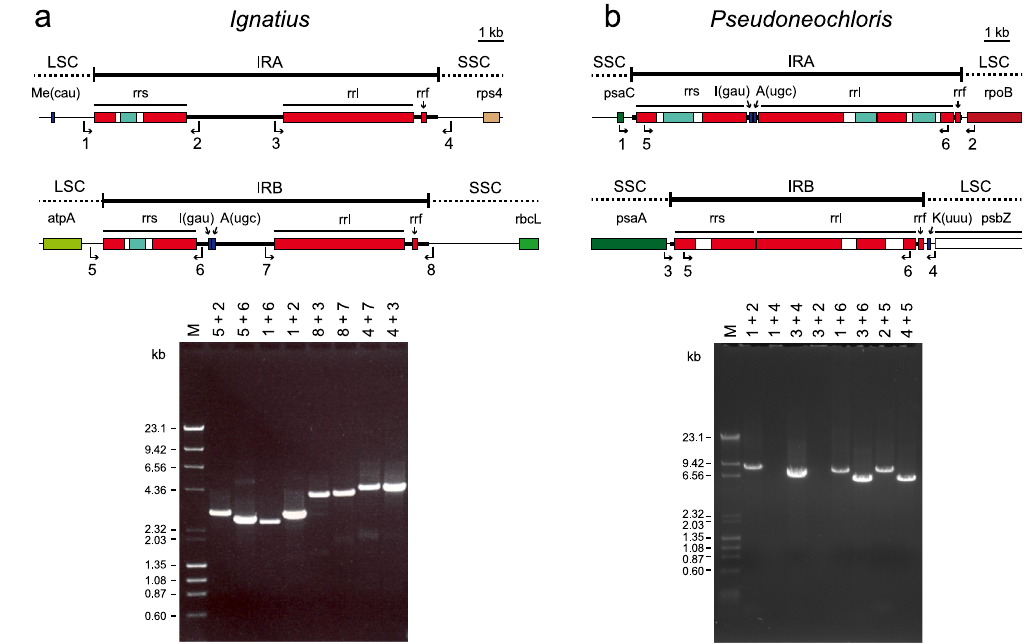
Figure 6. Analysis of flip-flop recombination in the Ignatius ( a ) and Pseudoneochloris ( b ) chloroplast genomes. PCR assays using eight different pairs of primers were carried out to test whether the non-identical IRs in each algal genome undergo homologous recombination. Primer locations and polarities are indicated by numbered arrows on the diagrams showing the organizations of the IR copies (see Supplementary Table S3 for the primer sequences). PCR products were analyzed by electrophoresis on agarose gels; the numbers above the gel lanes indicate the combinations of primers